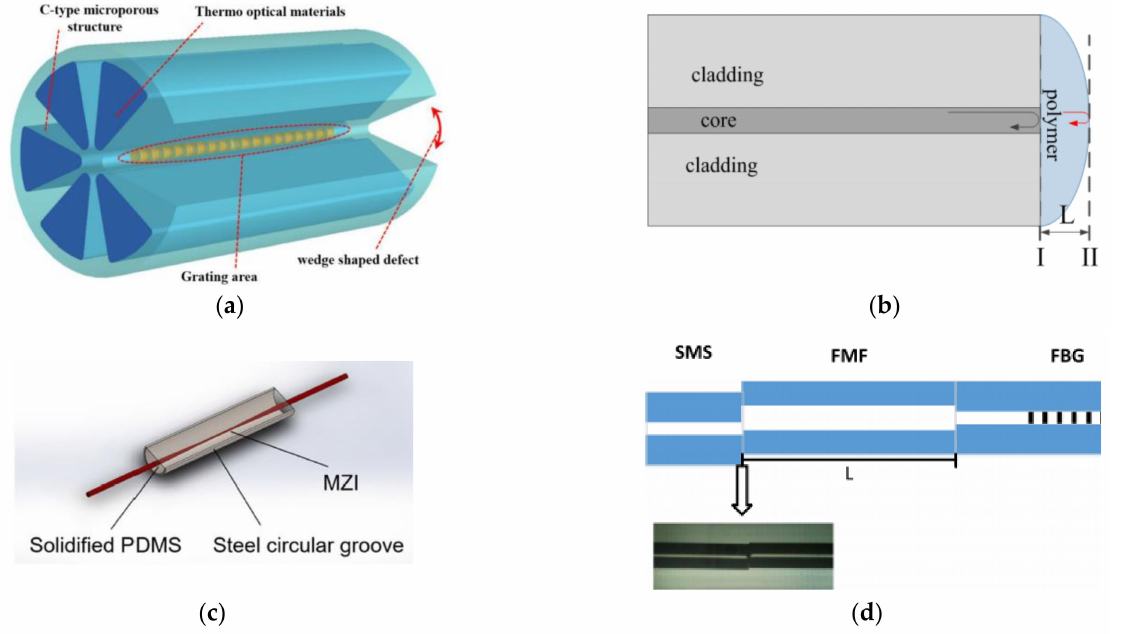
Figure 5. ( a ) Structure design of C-type micro-structured FG [111]. ( b ) Schematic diagram of the fiber-tip FPI sensor [114]. ( c ) Schematic diagram of the all-encapsulated and semi-encapsulated MMZI [116]. ( d ) Diagram of the cascaded MZI with SF